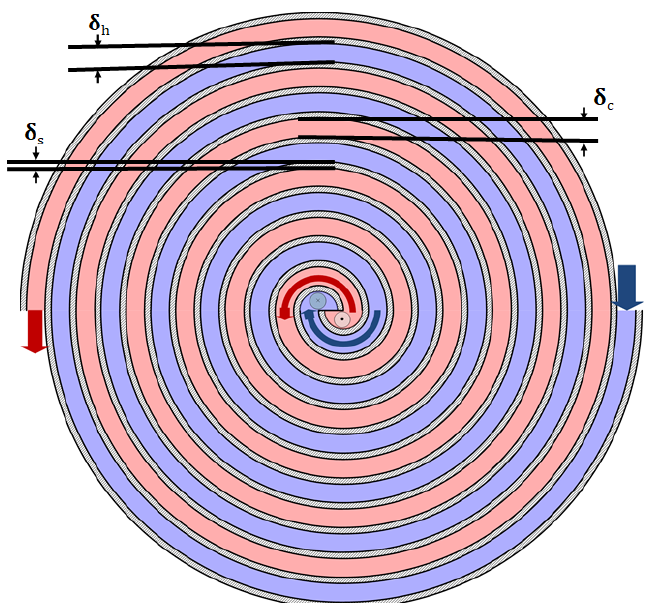
Figure A2. The inner structure for a spiral heat